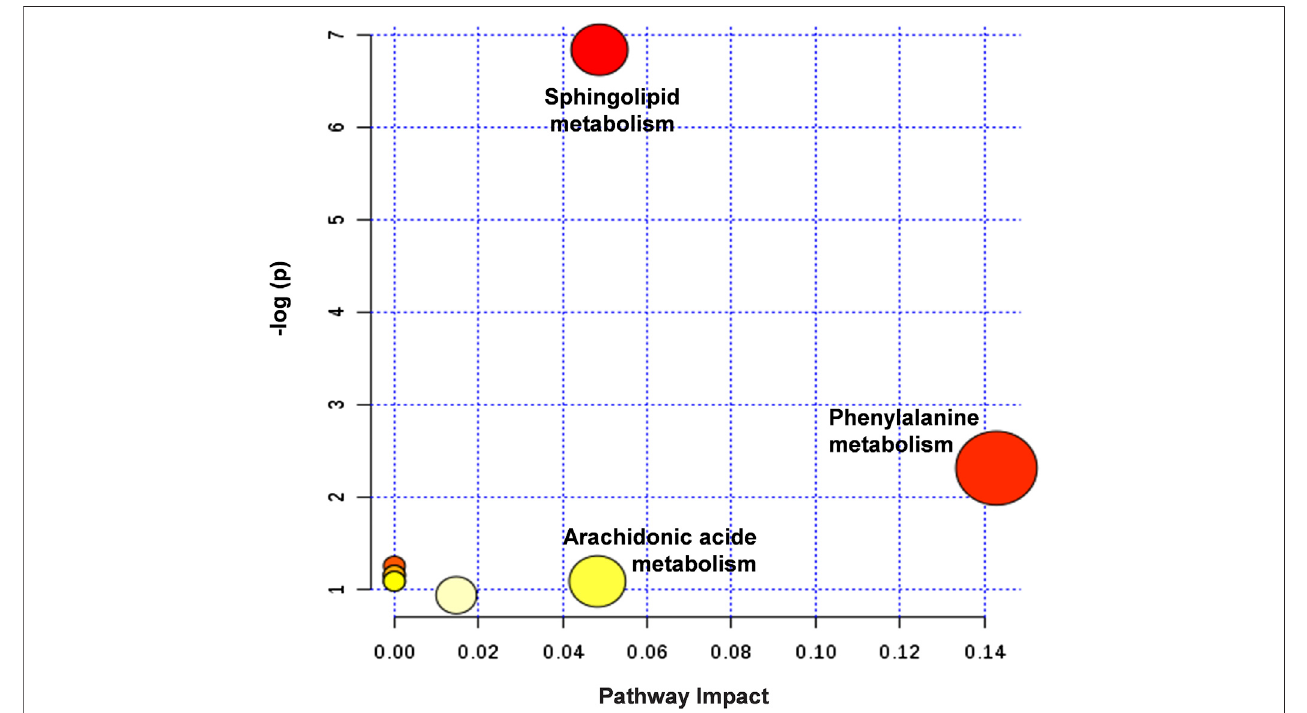
FIGURE 8 | Summary of potential metabonomic pathways in MI injury treated by HLJDT. Among these metabolic pathways, phenylalanine metabolism, sphingolipid metabolism, and arachidonic acid metabolism were fi ltered out, which were considered as the most signi fi cant metabolic pathways.